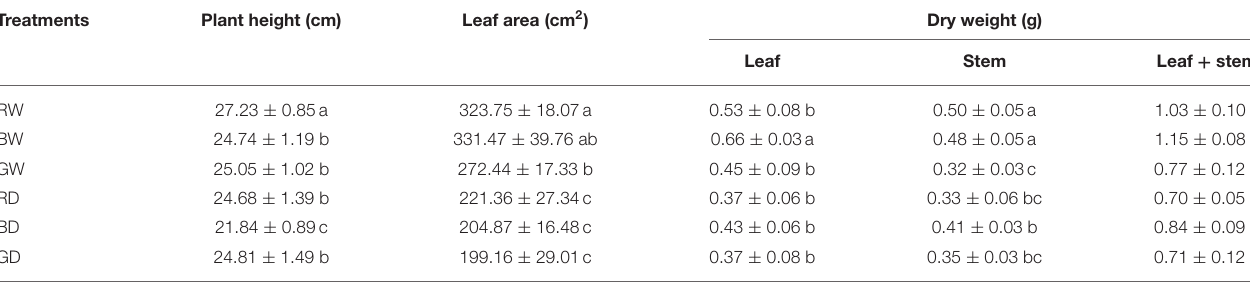
TABLE 1 | The growth of tomato seedlings under different water and light spectral conditions ( n = 6–8). Treatments Plant height